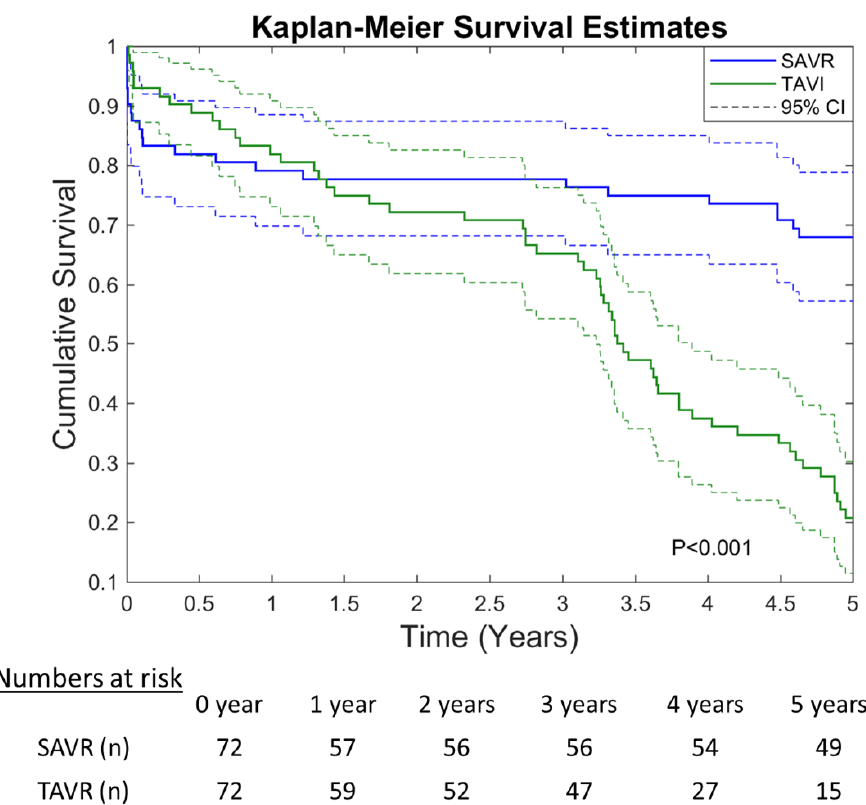
Figure 3. Five-year Kaplan–Meier survival curves (CI—Confidence Interval)